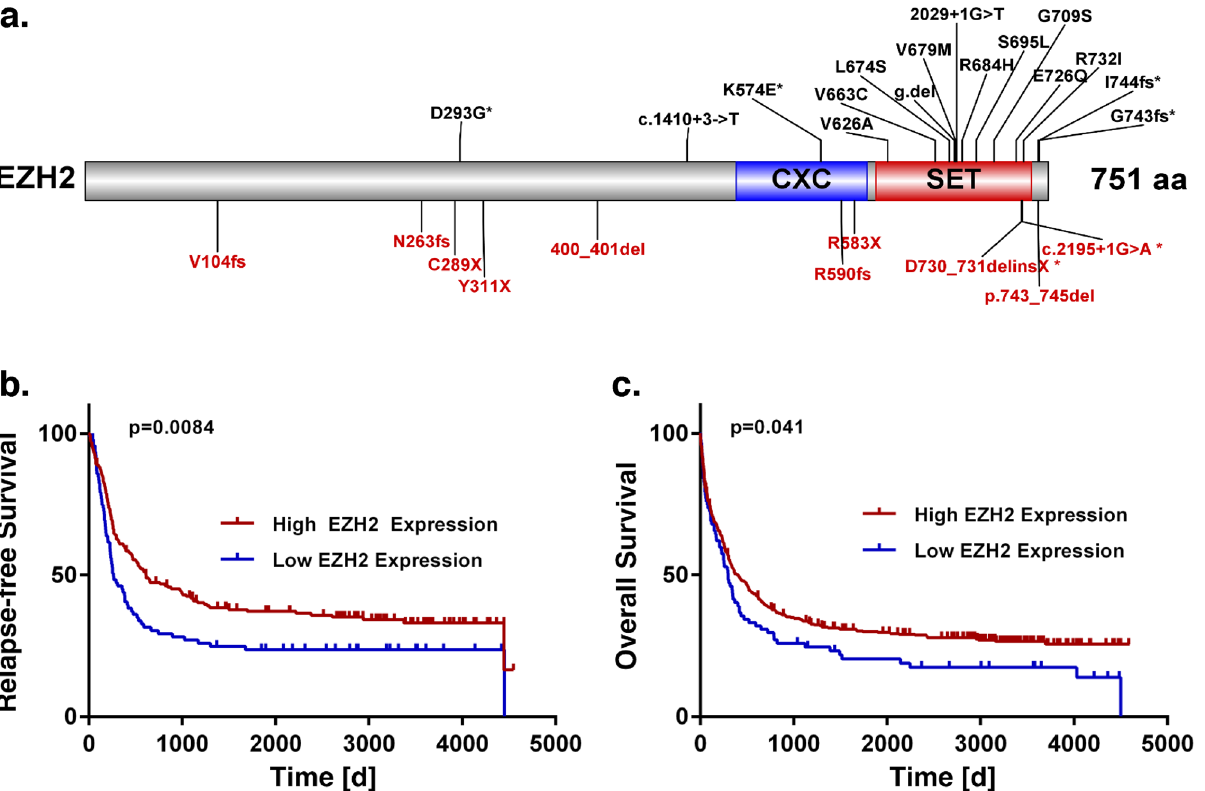
Figure 1. Recurrent EZH2 mutations. (a) Schematic overview of EZH2 protein structure (NM_004456.4) and identified mutations (27 in total, c.2195+1G>A appeared twice) in a cohort of 664 AML patients at diagnosis. Functional domains are indicated at distinct locations and truncating mutations are displayed in red. Patients from Metzeler et al. 2016 (AMLCG-1999, AMLCG-2008). (b–c) Survival analysis of patients with low or high EZH2 mRNA expression at the time point of diagnosis. EZH2 high and low groups defined by the upper and lower quartile of EZH2 mRNA expression, independent of mutation status. (b) Relapse-free survival (RFS). (c) Overall survival (OS). Patients from AMLCG 1999 (GSE37642), n = 517. 21 patients harboured an EZH2 mutation. P-value calculated by log-rank